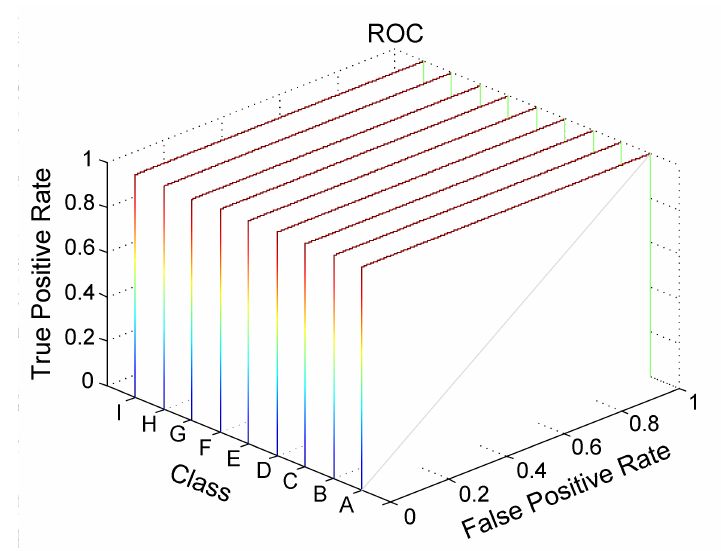
Figure 7. Receiver operating characteristic (ROC) curves that depict the trade-offs between the true positive and false positive classification of the proposed scheme for each class of power quality disturbance (PQD).